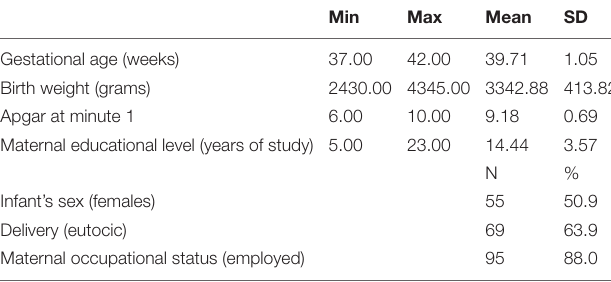
TABLE 3 | Descriptive statistics.